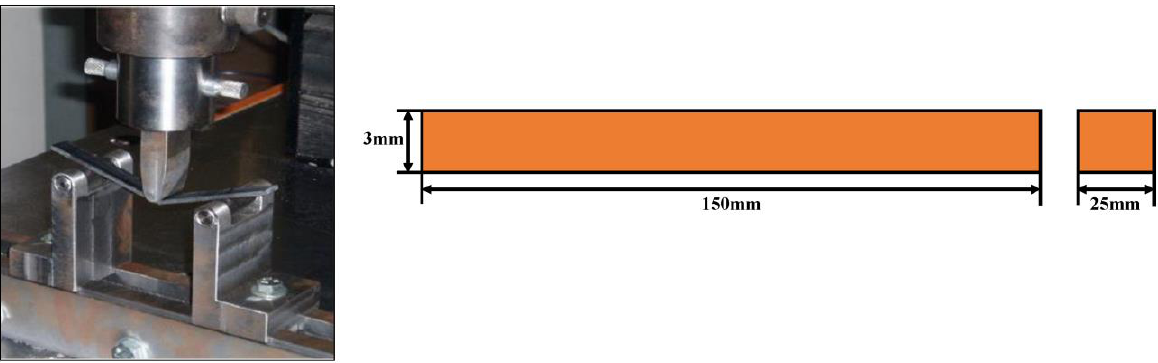
Figure 4. Flexural test arrangement.